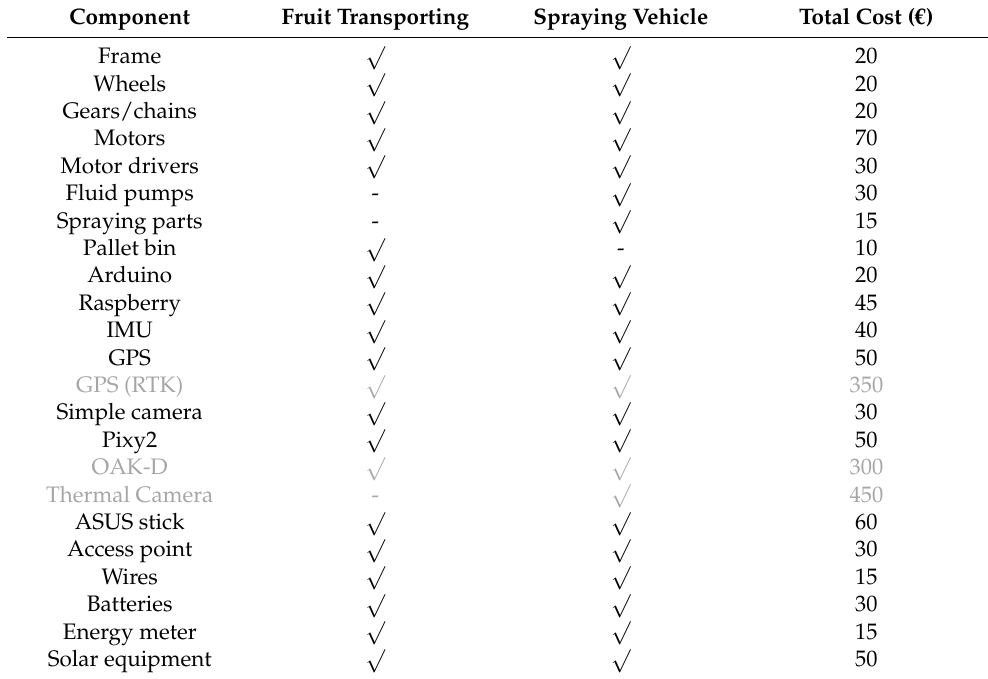
Table 1. Indicative cost analysis of the proposed robotic